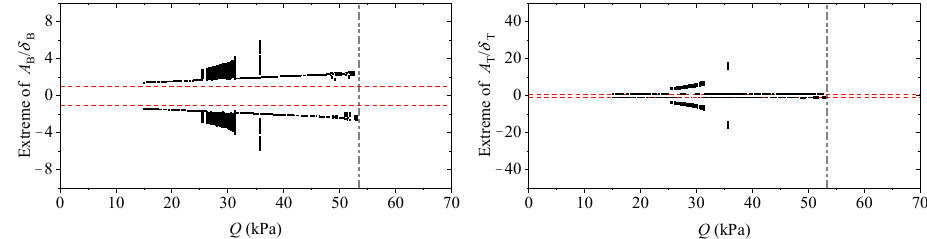
Figure 22. Time-domain bifurcation diagrams of LCO responses when x ( 0 ) = [100 δ B , 100 δ T , 0.0, 0.0] T at δ B / δ T =